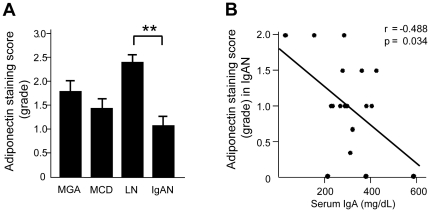
The adiponectin staining score in the glomeruli of renal biopsy specimens and the relationship between the adiponectin staining score and serum IgA in patients with IgA nephropathy (IgAN).(A) The adiponectin staining score in IgAN was significantly decreased in IgAN patients compared with that in patients with lupus nephritis (LN). Each column shown the means ± SE. MGA, n = 9; MCD, n = 8; LN, n = 17; and IgAN, n = 19. **P<0.01. (B) A significantly negative correlation was found between the adiponectin staining score and serum IgA in IgAN patients (n = 19) (r = −0.488, P = 0.034).